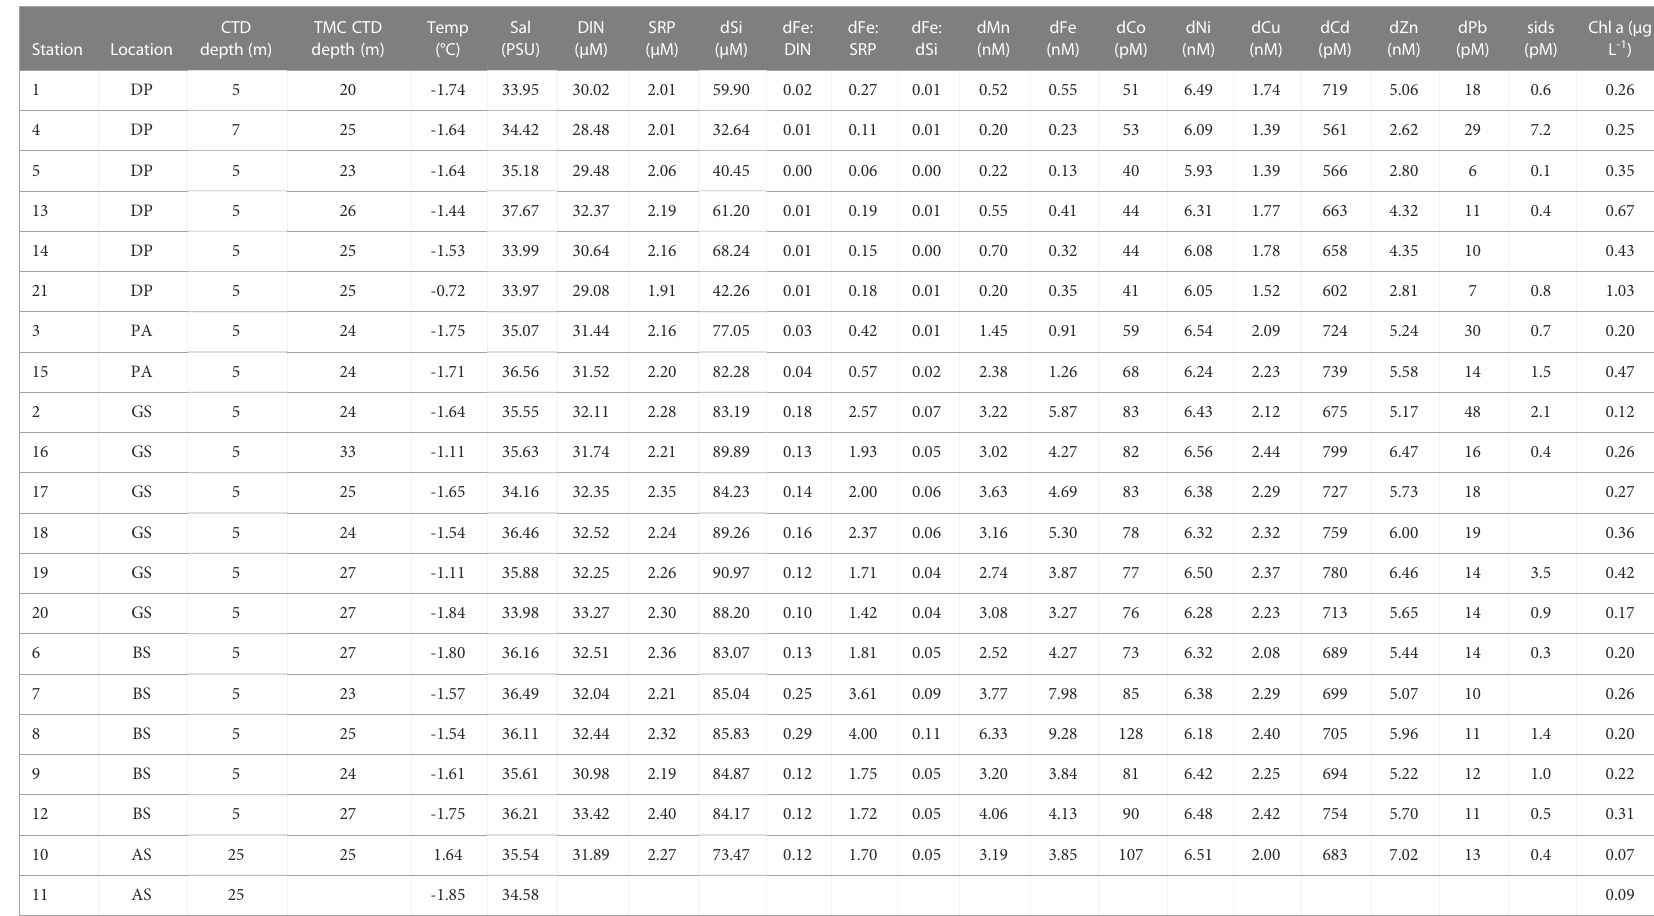
TABLE 1 Environmental parameters for surface data of the NBP16-08